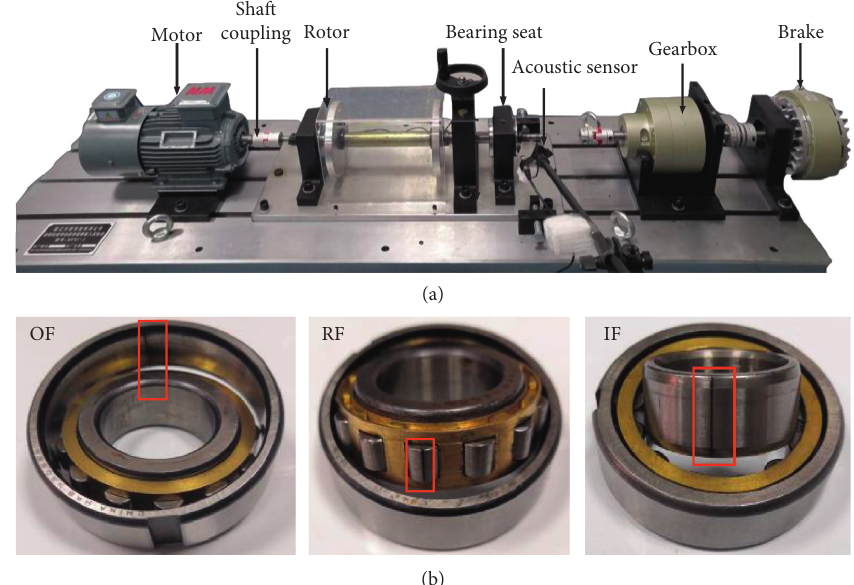
Figure 4: (a) Bearing fault test rig and (b) three fault